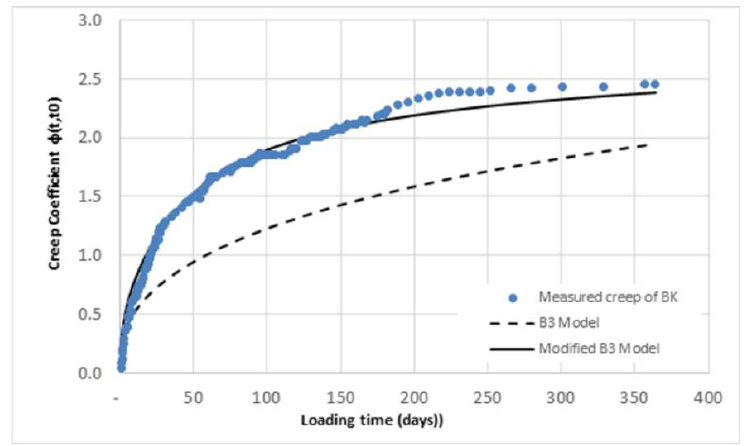
Figure 12. Comparison of creep models and measured creep of BK.